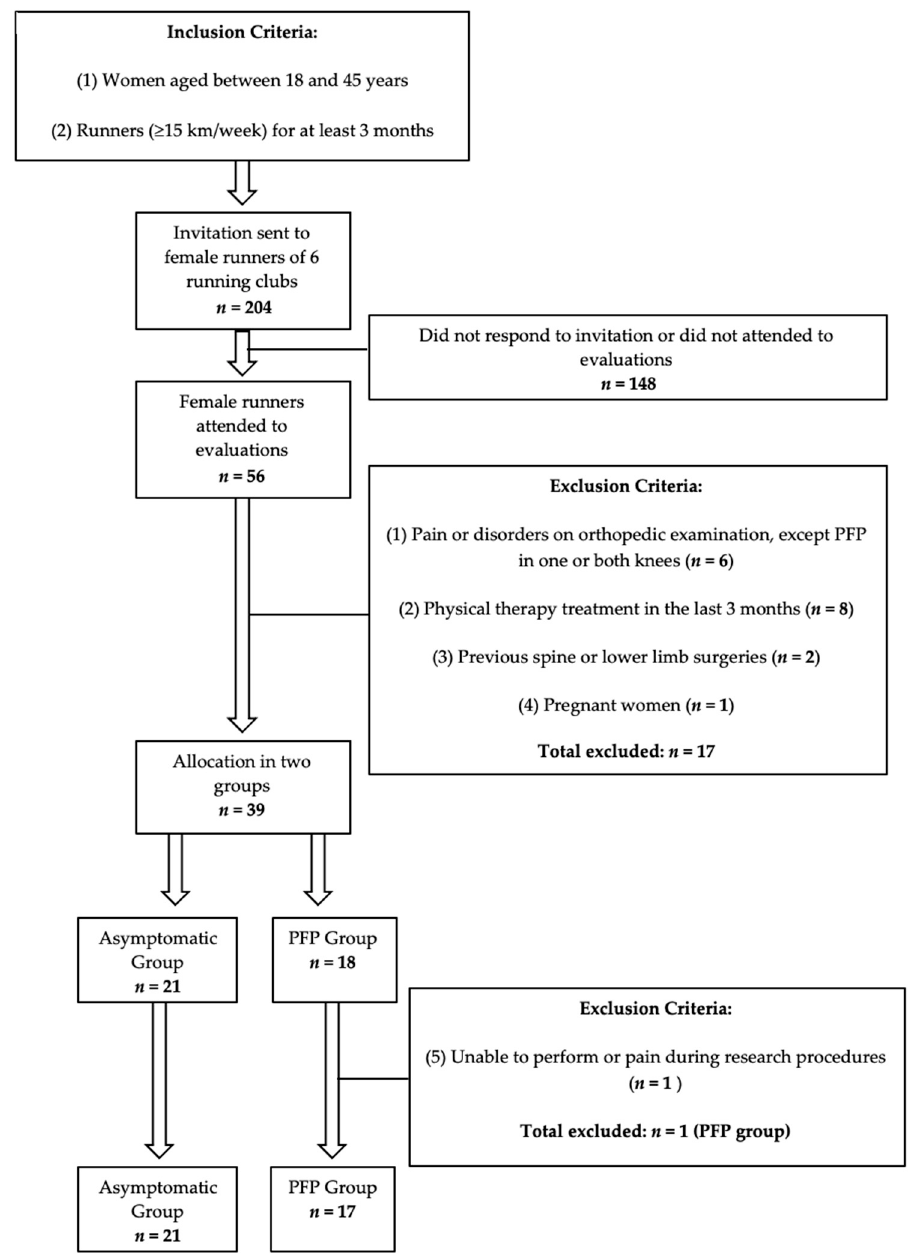
Figure 1. Participant selection process chart. Abbreviations: PFP: patellofemoral pain.